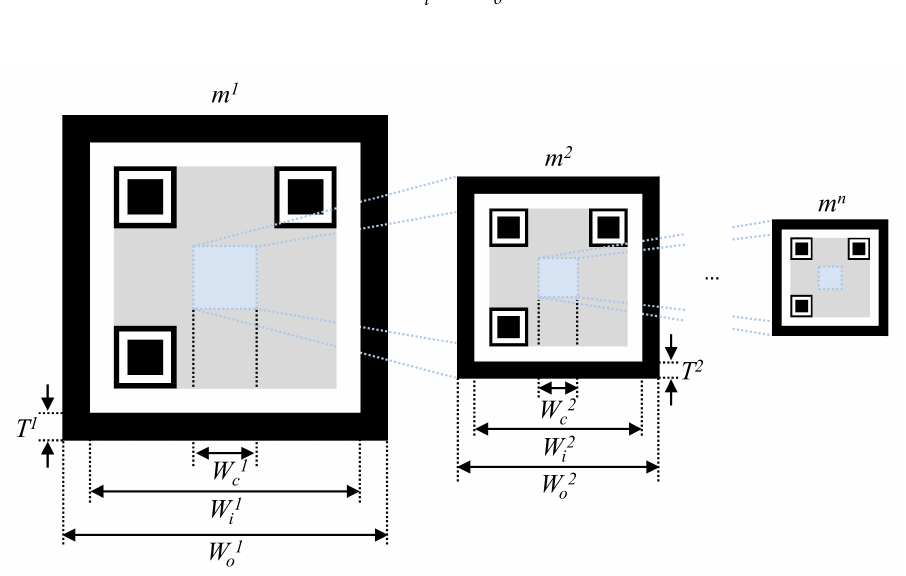
Figure 4. Structure of the proposed nested